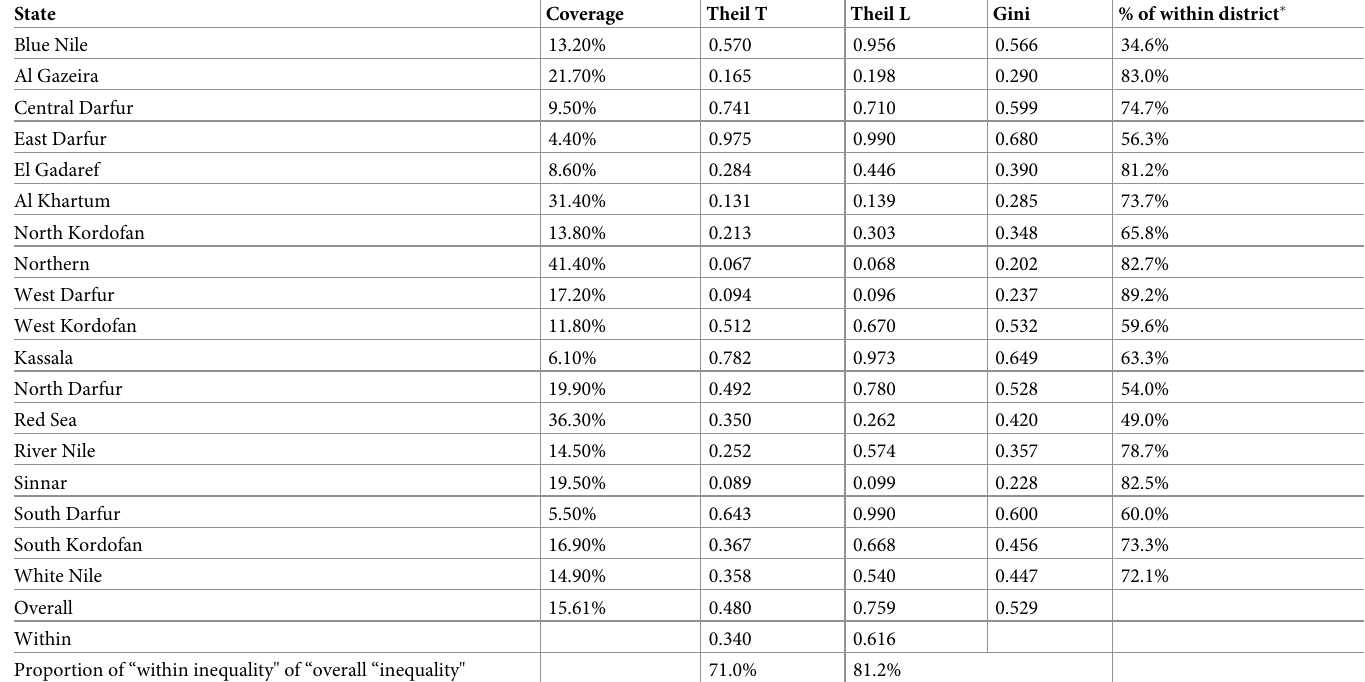
Table 1. Coverage of improved latrines at the household level.